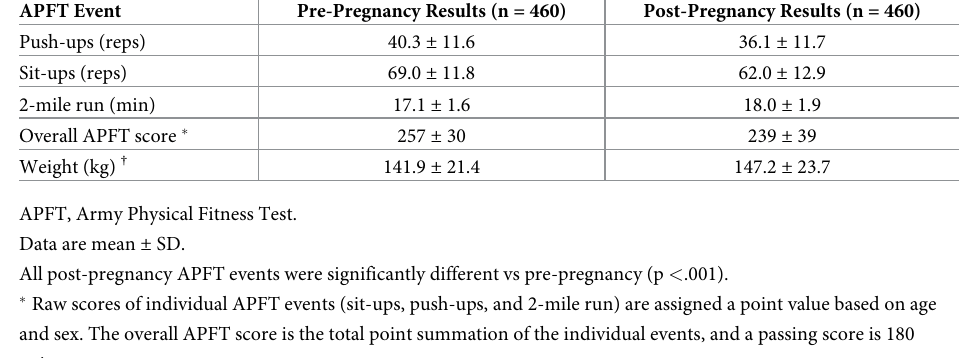
Analysis of BMI changes across the combined 6-week and 12-week cohorts APFT height and weight data with calculated BMI were recorded for 229 women at the time of the pre-pregnancy and postpartum APFT. In the 6-week cohort, the failure rates increased from 4.7% to 11.6% (p = 0.008); in the 12-week cohort, the failure rates increased from 2.9% to 11.8% (p = 0.335). Combined BMI failure rates increased from 4.4% pre-pregnancy to 11.7% post (p < 0.001). Increases in failure rates did not differ between the 6-week and 12-week leave groups. Using data from the combined cohort, unadjusted analysis of BMI showed female sol- diers who were officers, had passed the APFT and BMI standards pre-pregnancy, had weight gain within IOM standards, and had more rapid weight loss in the first 6–8 weeks postpartum, Table 3. Raw APFT score and weight comparison before and after pregnancy for combined cohort.